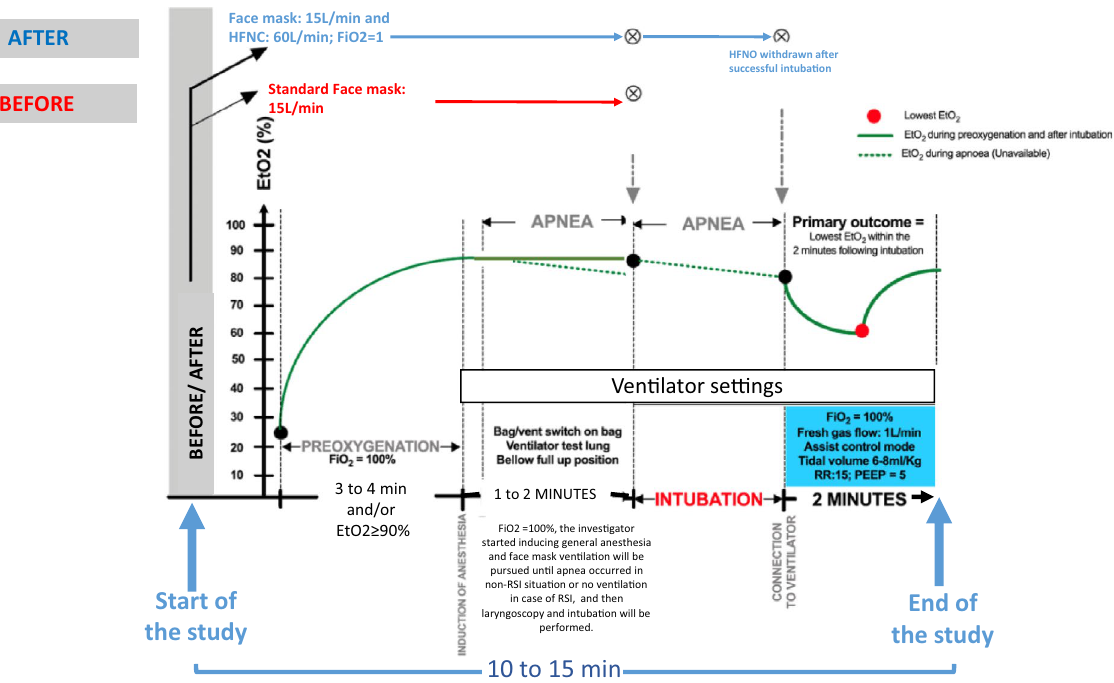
Fig. 1 Study design. EtO2 end‑tidal oxygen, PEEP positive end expiratory pressure, HFNO High‑Flow Nasal cannula Oxygen, RR respiratory rate, RSI rapid sequence